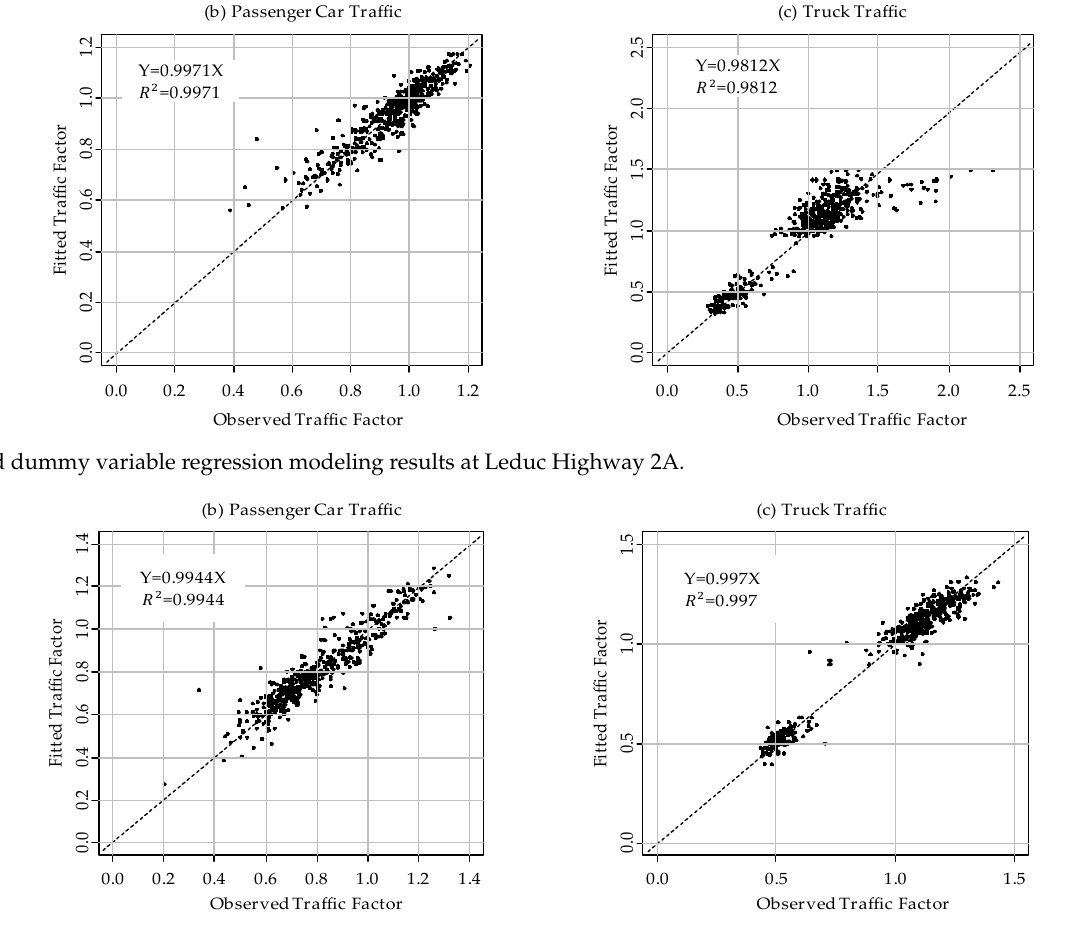
Figure 7. Fitted dummy variable regression modeling results at Leduc Highway 2.